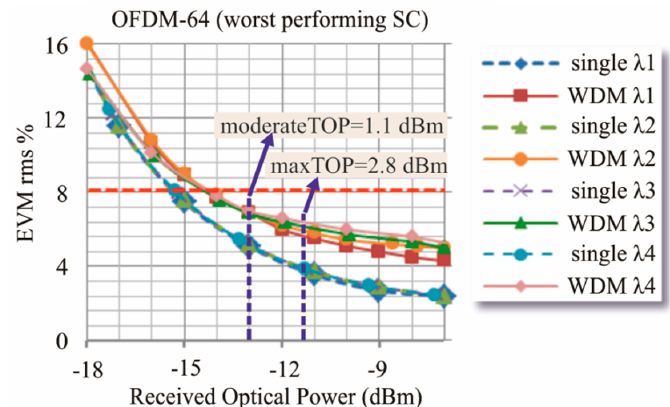
Figure 10. EVM versus ROP (dBm) for the worst performing SC of each WDM channel. Respective EVM curves for the single- λ transmission at λ 1 , λ 2 , λ 3 , λ 4 .